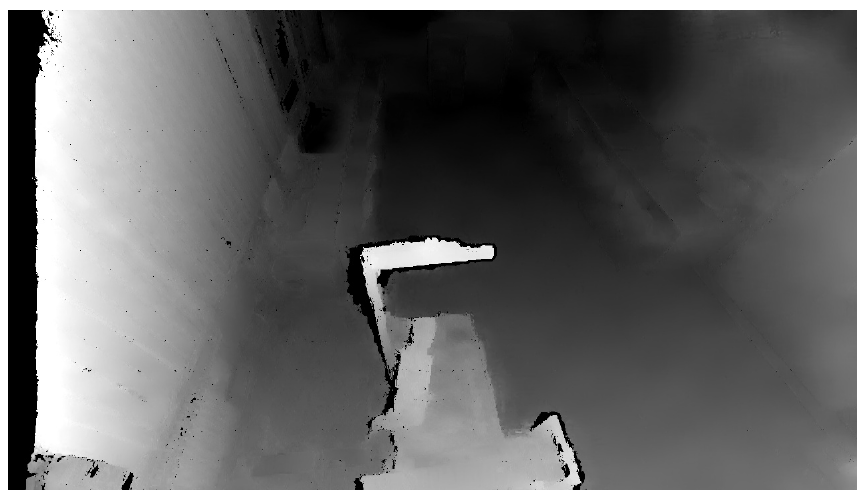
Figure 6. Depth image of the